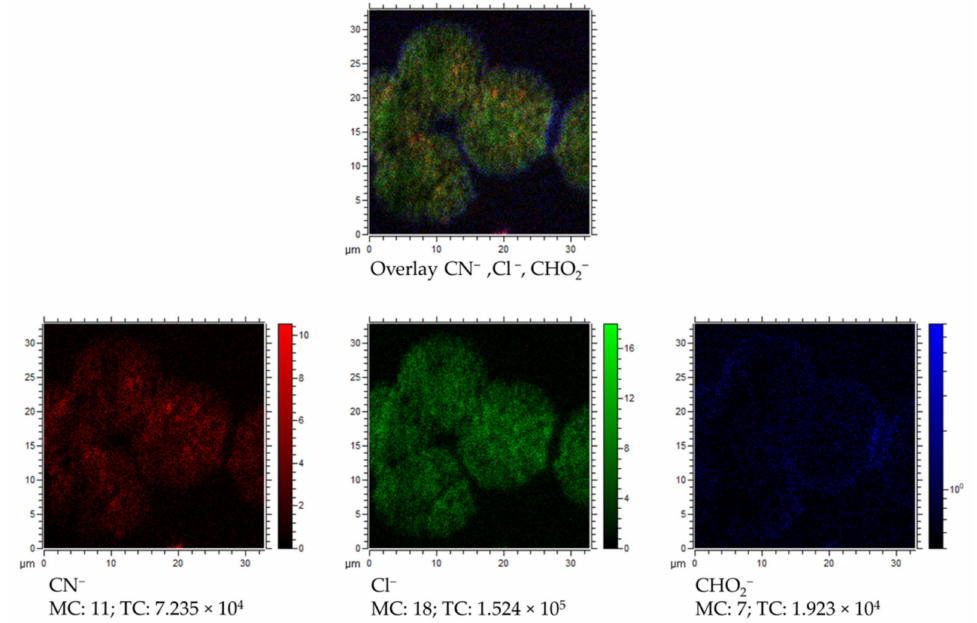
Figure 10. Overlay of TOF–SIMS distribution maps of CN − (red), Cl − (green), and CHO 2 − (blue) for partially covered with sediments surface of explanted